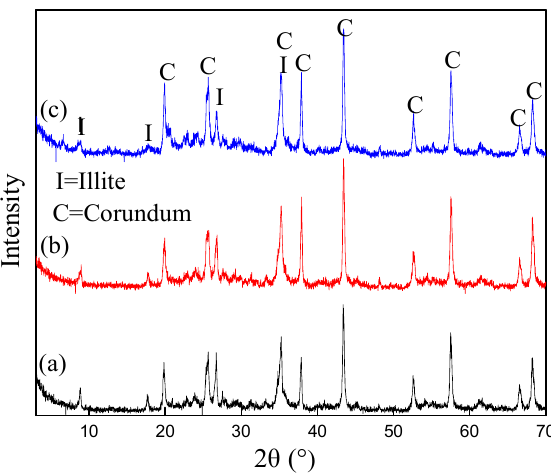
Figure 13. The XRD patterns of treated bauxites (( a ): bauxite roasted at 550 °C. ( b ): leached with 1.2 mol/L H 2 SO 4 , ( c ): leached with 4 mol/L H 2 SO 4 ).